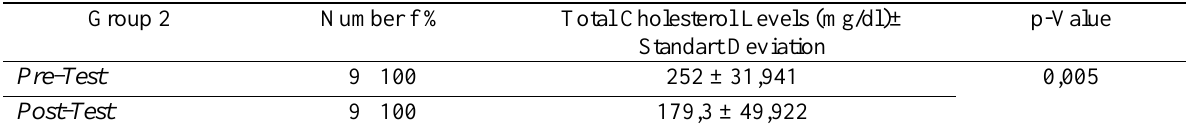
Table 2. Average total blood cholesterol levels before and after treatment in group 2 Group